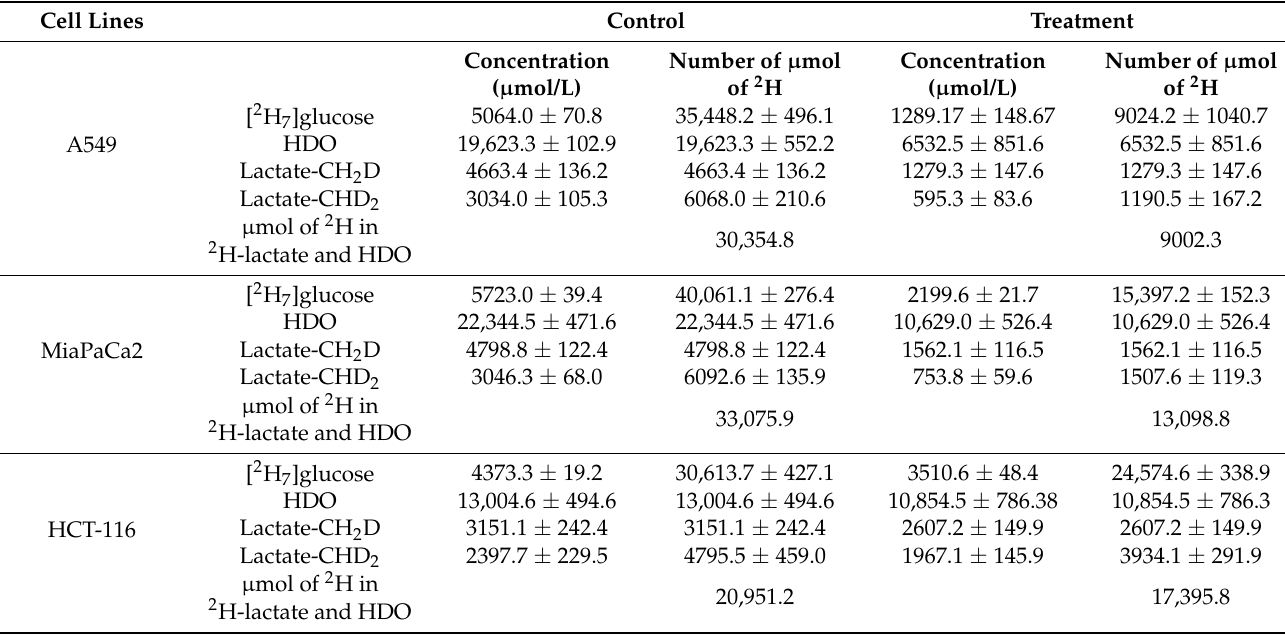
Table 1. 2 H mass balance between consumed [ 2 H 7 ]glucose and produced HDO and 2 H-lactate. Cell